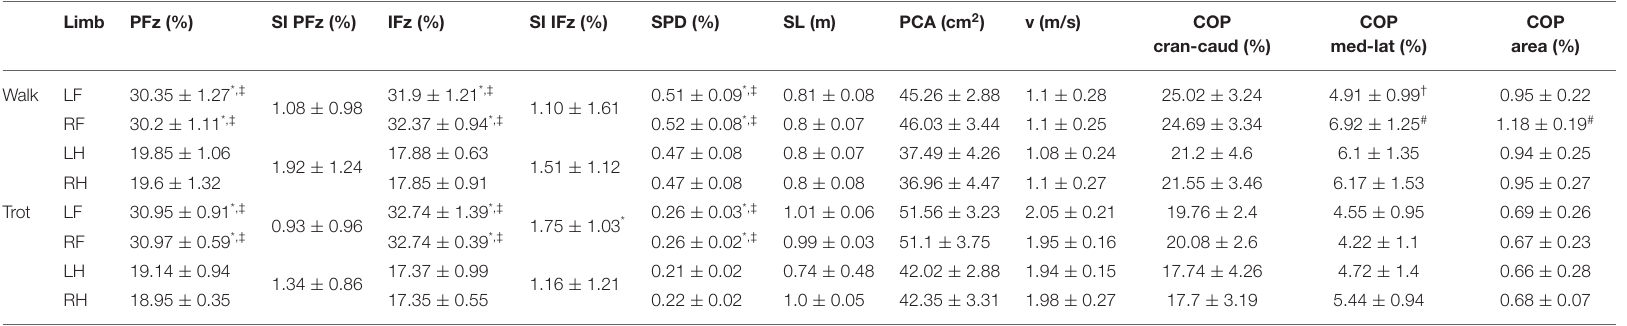
* Indicate a significant difference between the ipsilateral limb pairs; † between contralateral limb pairs; ‡ between diagonal limb pairs; # differences between the control and the boot wearing conditions.